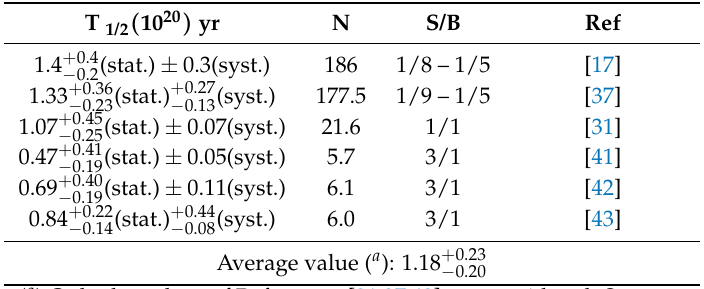
excited level of 150 Sm measured so 1